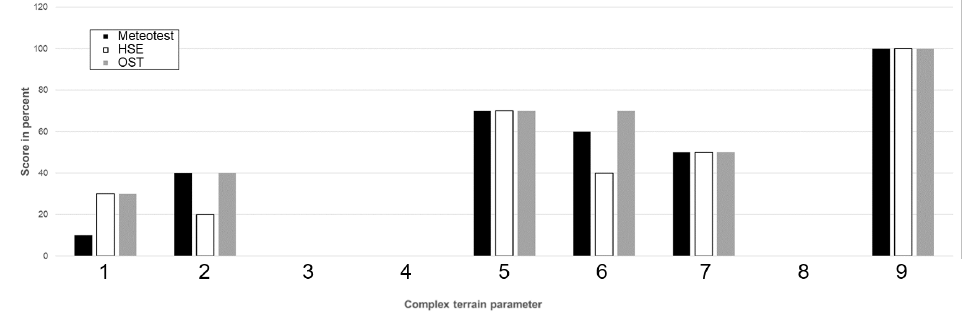
Figure A4. Answers to the ten complex terrain questions for Site